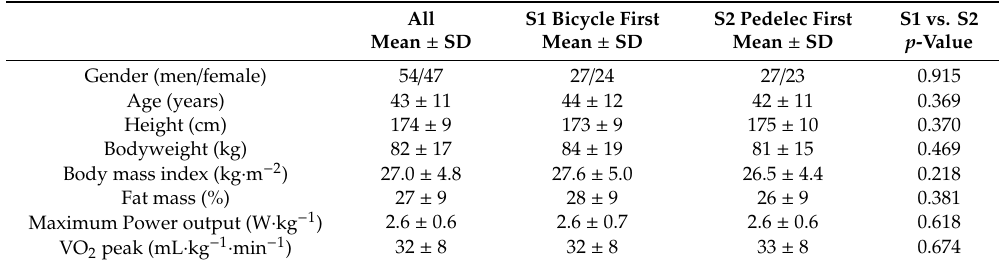
Table 1. General subject information ( n = 101). S1 and S2 display sequence association of S1: bicycle first vs. S2: pedelec